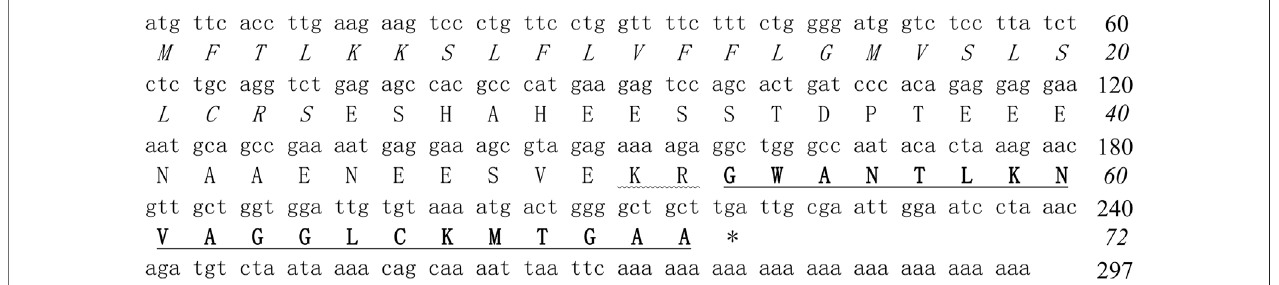
FIGURE 1 | The cDNA sequence of antioxidin-NV precursor. Deduced amino acid sequence is shown below the cDNA sequence. The putative signal peptide is italicizedandtheaminoacidsequenceofmaturepeptideisunderlinedandbold.Thestopcodon isindicatedbyan asterisk .Aminoacidnumbers ornucleotidenumbers are shown after the sequences.